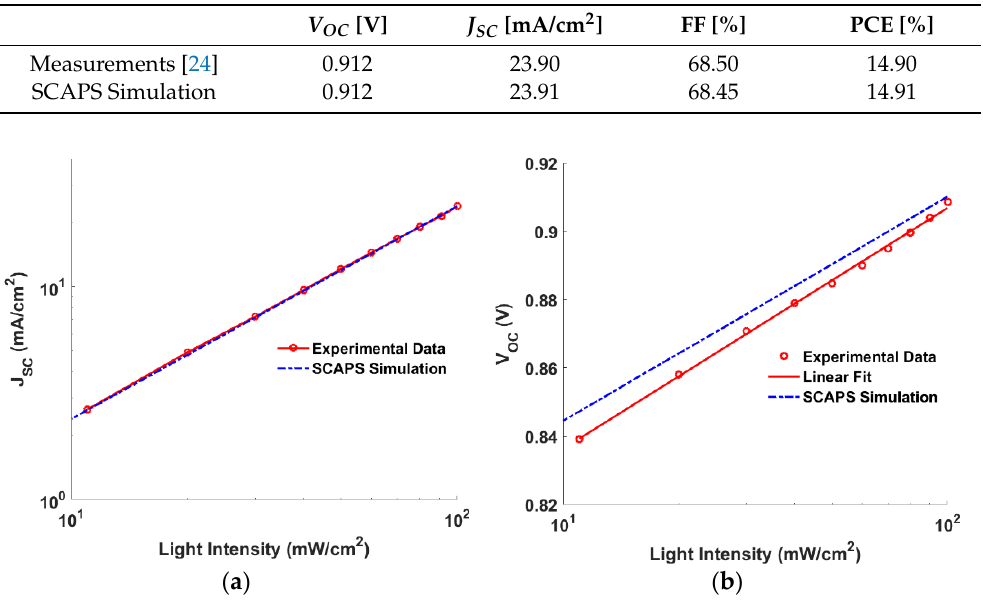
Figure 2. Calibration of calculated vs experimental data ( a ) J -V characteristics and ( b ) EQE spectra. Table 3. Solar cell key metrics extracted from illuminated J-V characteristics for both experimental and calculated data.